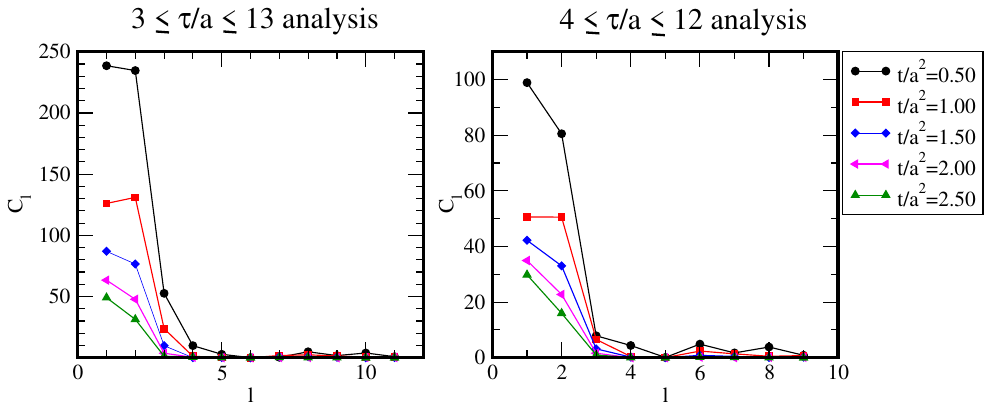
Figure 5 . The input correlation function in the IR basis ( C l ) as a function of the label l